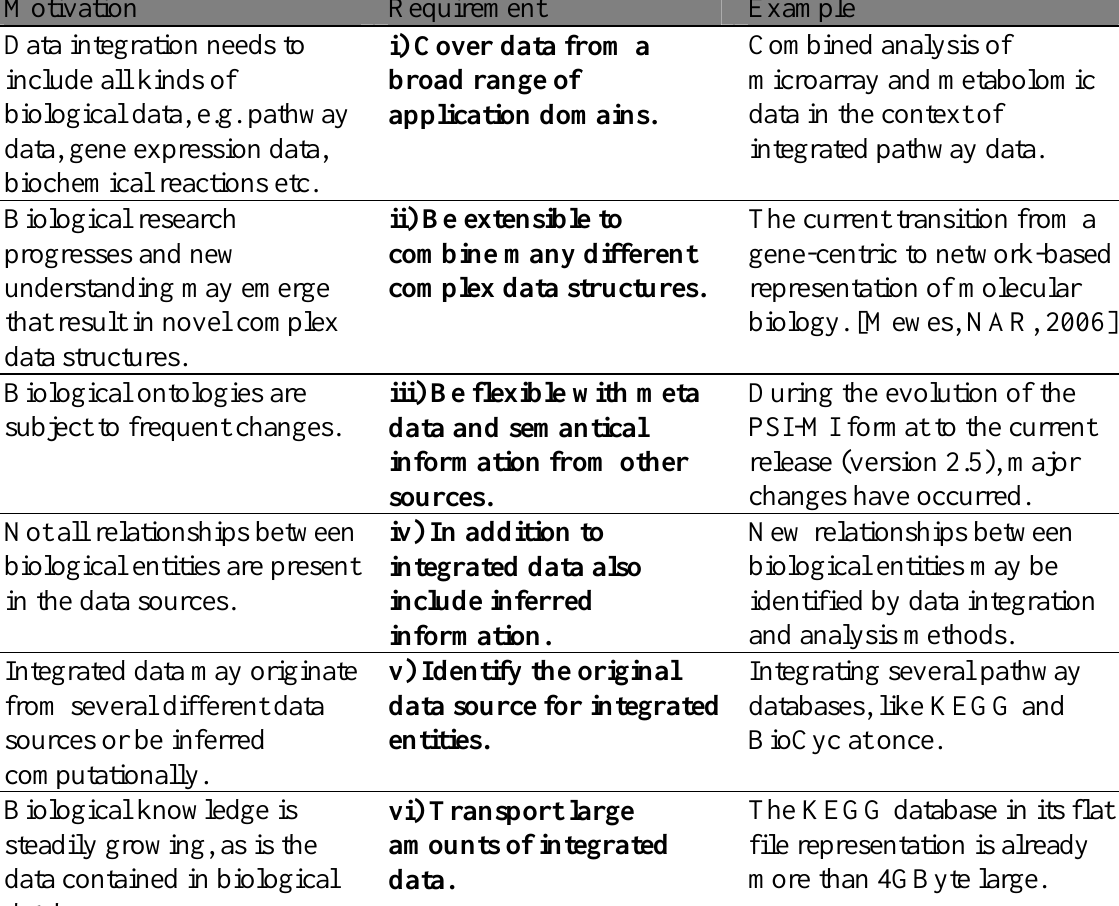
Table 1 Requirements for exchanging integrated